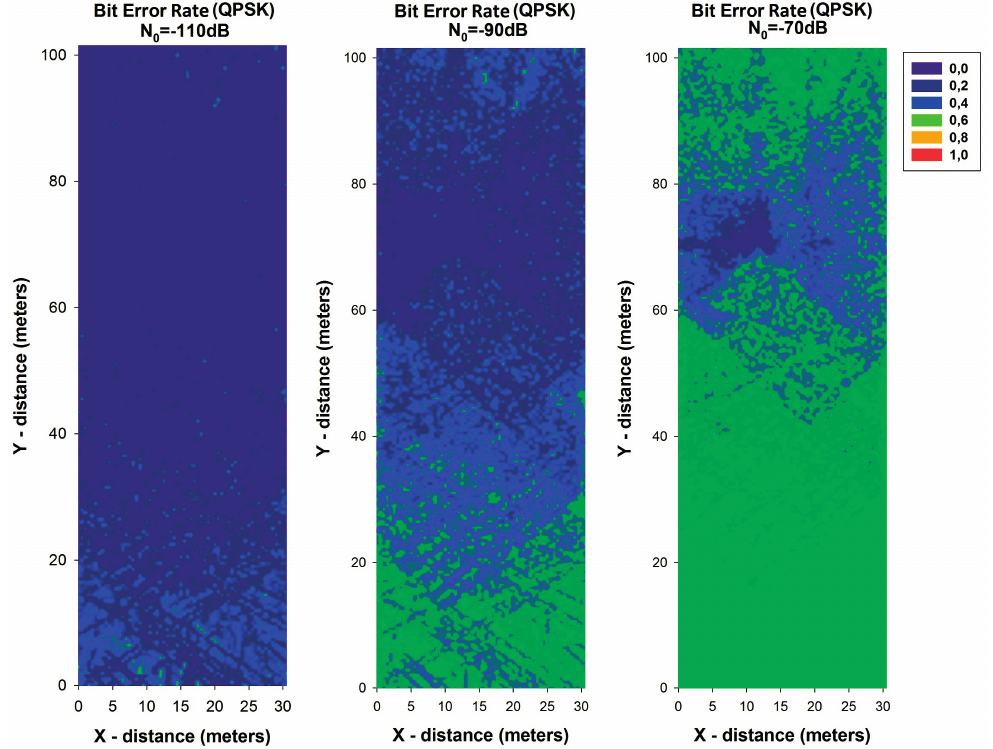
Figure 11. Bit Error Rate for QPSK modulation for different values of N 0 for data rate of 57,600